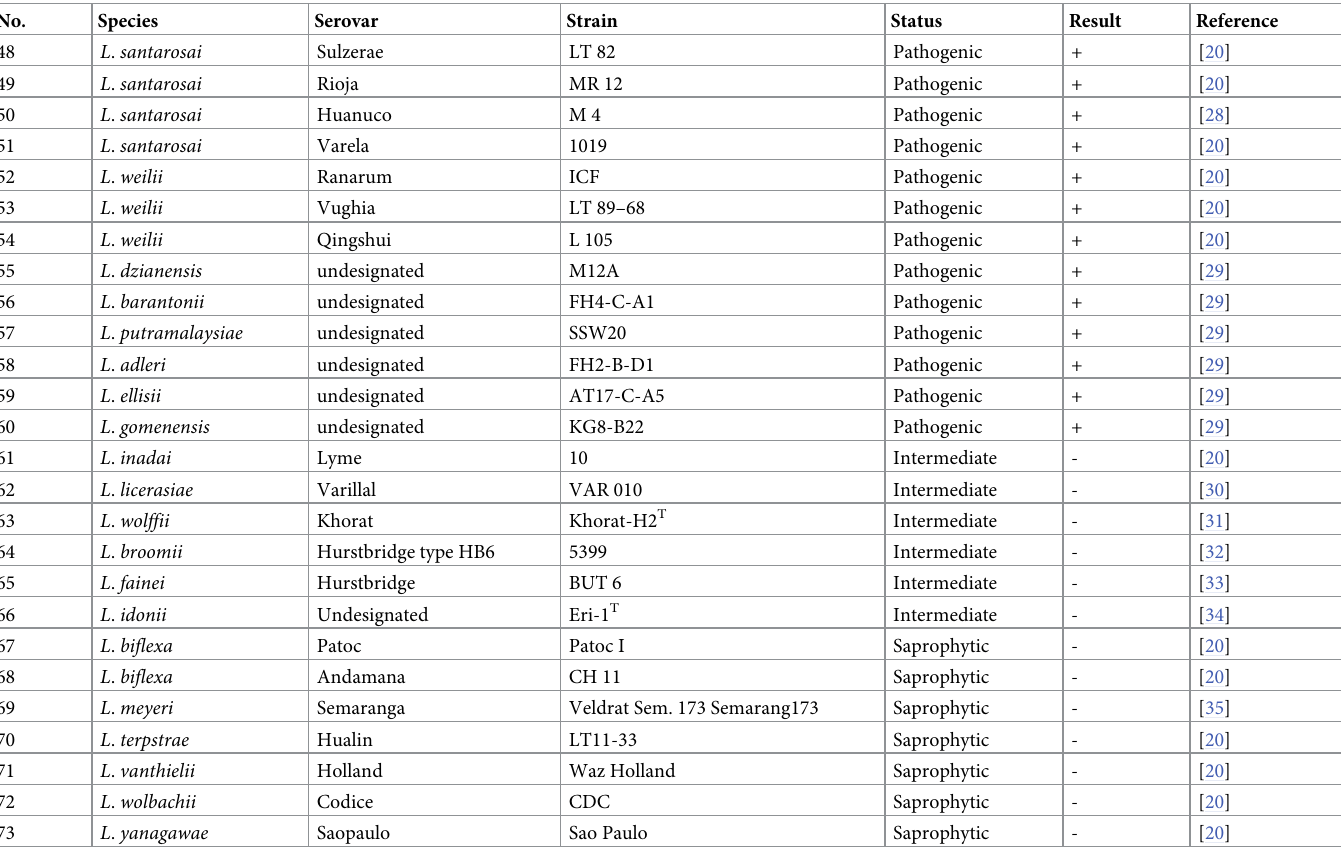
(Germany). Genomic DNA of Leptospira strains in spiked blood, serum and urine were extracted using easyMAG automated system (bioMe´rieux, Marcy l’Etoile, France) according to the manufacturer’s recommendation. The quality and quantity of leptospiral DNA was esti- mated by measuring the absorbance of DNA using the spectrophotometer ND-1000 Nanodrop (3411 Silverside Rd, Bancroft Building, Wilmington, DE 19810, USA). Leptospira interrogans and therefore a total genome size of 5 Mb was used to estimate the equivalent number of strains (Table 1) were standardized to a concentration equivalent of 10 2 genome copies/ μ l. In order to check the efficiency of the extraction method, a concentration of 0.58 pg equivalent to 100 copies of IC DNA was added to the spiked blood, serum, urine and each clinical material prior to DNA isolation. DNA of all patient’s diagnostic materials used in this assay such as blood, serum and urine were isolated using the easyMAG automated system.